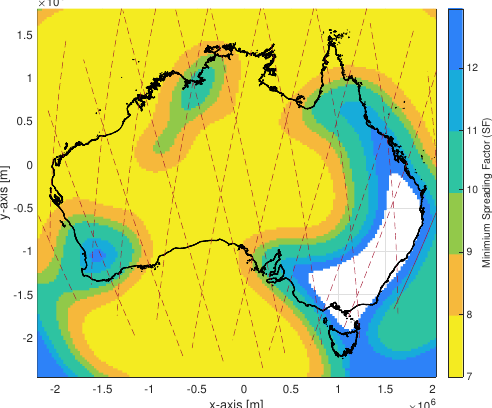
Figure 13. The minimum Spreading Factor that suitable for the simulated area based on the result of average SINR over a